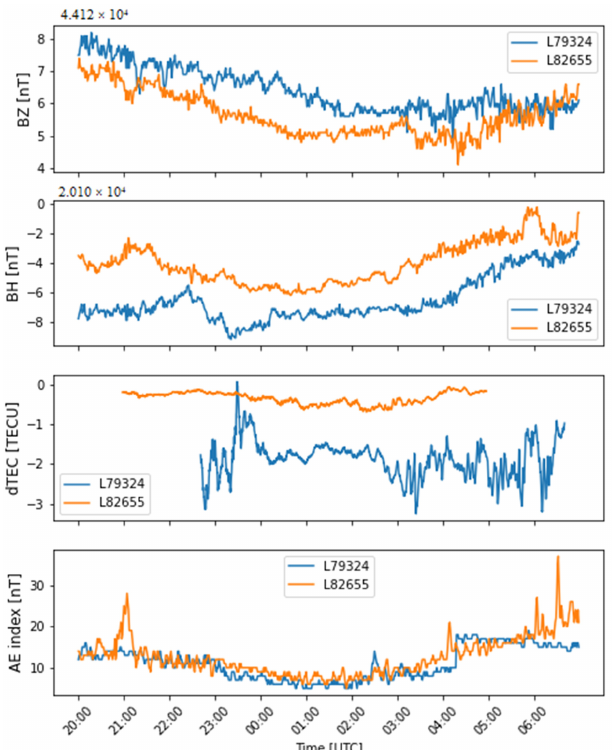
Figure 12. Geomagnetic field for DOU station and LOFAR dTEC signal for both observations. From top to bottom: vertical component of geomagnetic field (BZ), horizontal component of geomagnetic field (BH), sum of dTEC values of LOFAR baselines, auroral electrojet index value